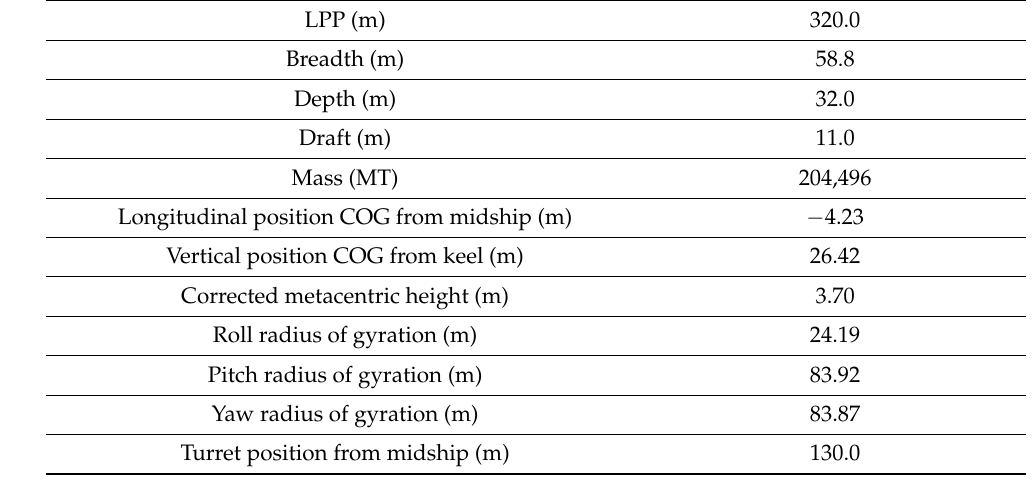
Table 1. The particulars of the FPSO.